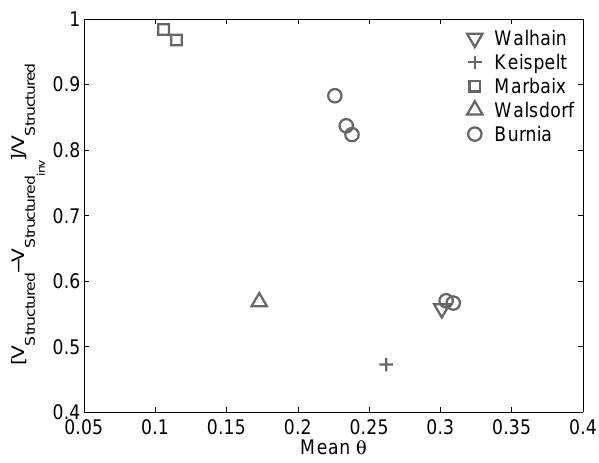
Fig. 6. Hydrographs from hydrologic simulation using the an- tecedent soil moisture maps from scenarios 1 to 5 for the field cam- paign in Marbaix, 15 April 2009. The average Random hydrograph is depicted as a dotted line on top of the 1000 hydrographs from the random antecedent soil moisture maps.